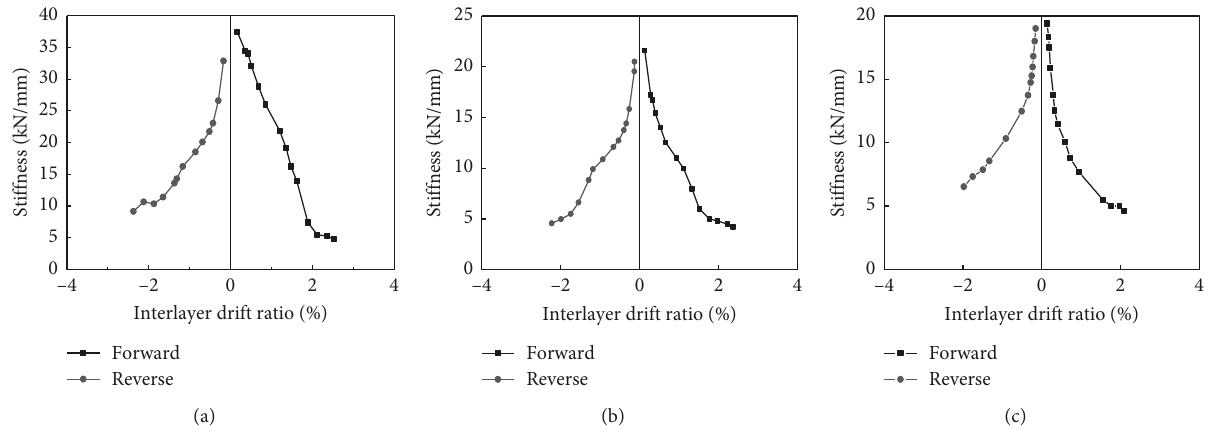
Figure 12: Stiffness degradation curves of the prestressed fabricated concrete frame. (a) First layer. (b) Second layer. (c) Third layer.